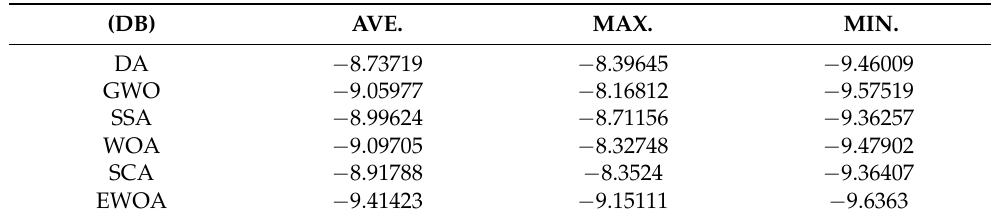
Table 6. Statistical results of the objective values obtained by different approach in the case with 50 populations and 120 elements.